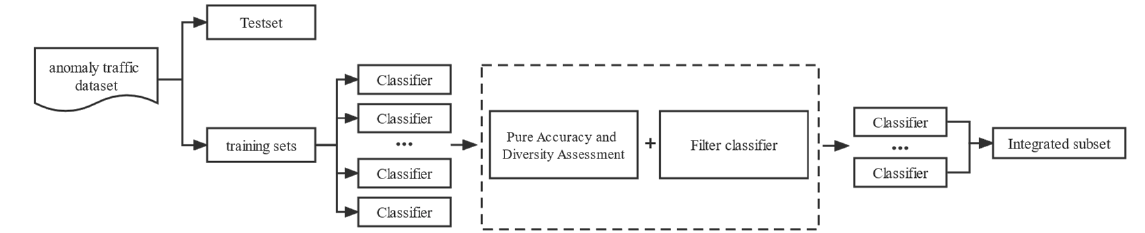
Figure 5. Three-way selection classi fi er evaluation ideas. Figure 5. Three‑way selection classifier evaluation